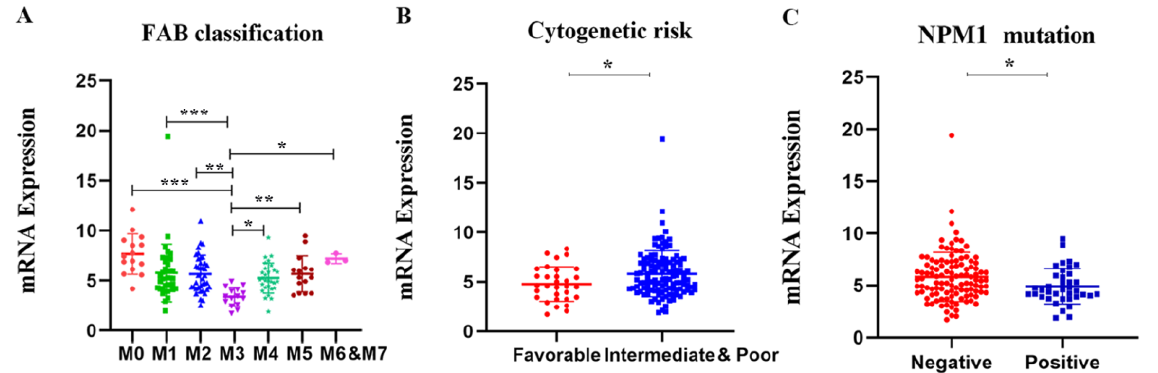
Figure 3. The mRNA expression levels of the APOBEC3G in various classes of AML in the TCGA database. Individual value plots representing APOBEC3G expression levels ( A ) in different FAB subtypes, * p < 0.05, ** p < 0.01, *** p < 0.001 vs. M3; ( B ) in different cytogenetic risks, * p < 0.05 vs. favorable group; ( C ) with NPM1 mutation versus wild type, * p < 0.05 vs. negative group.